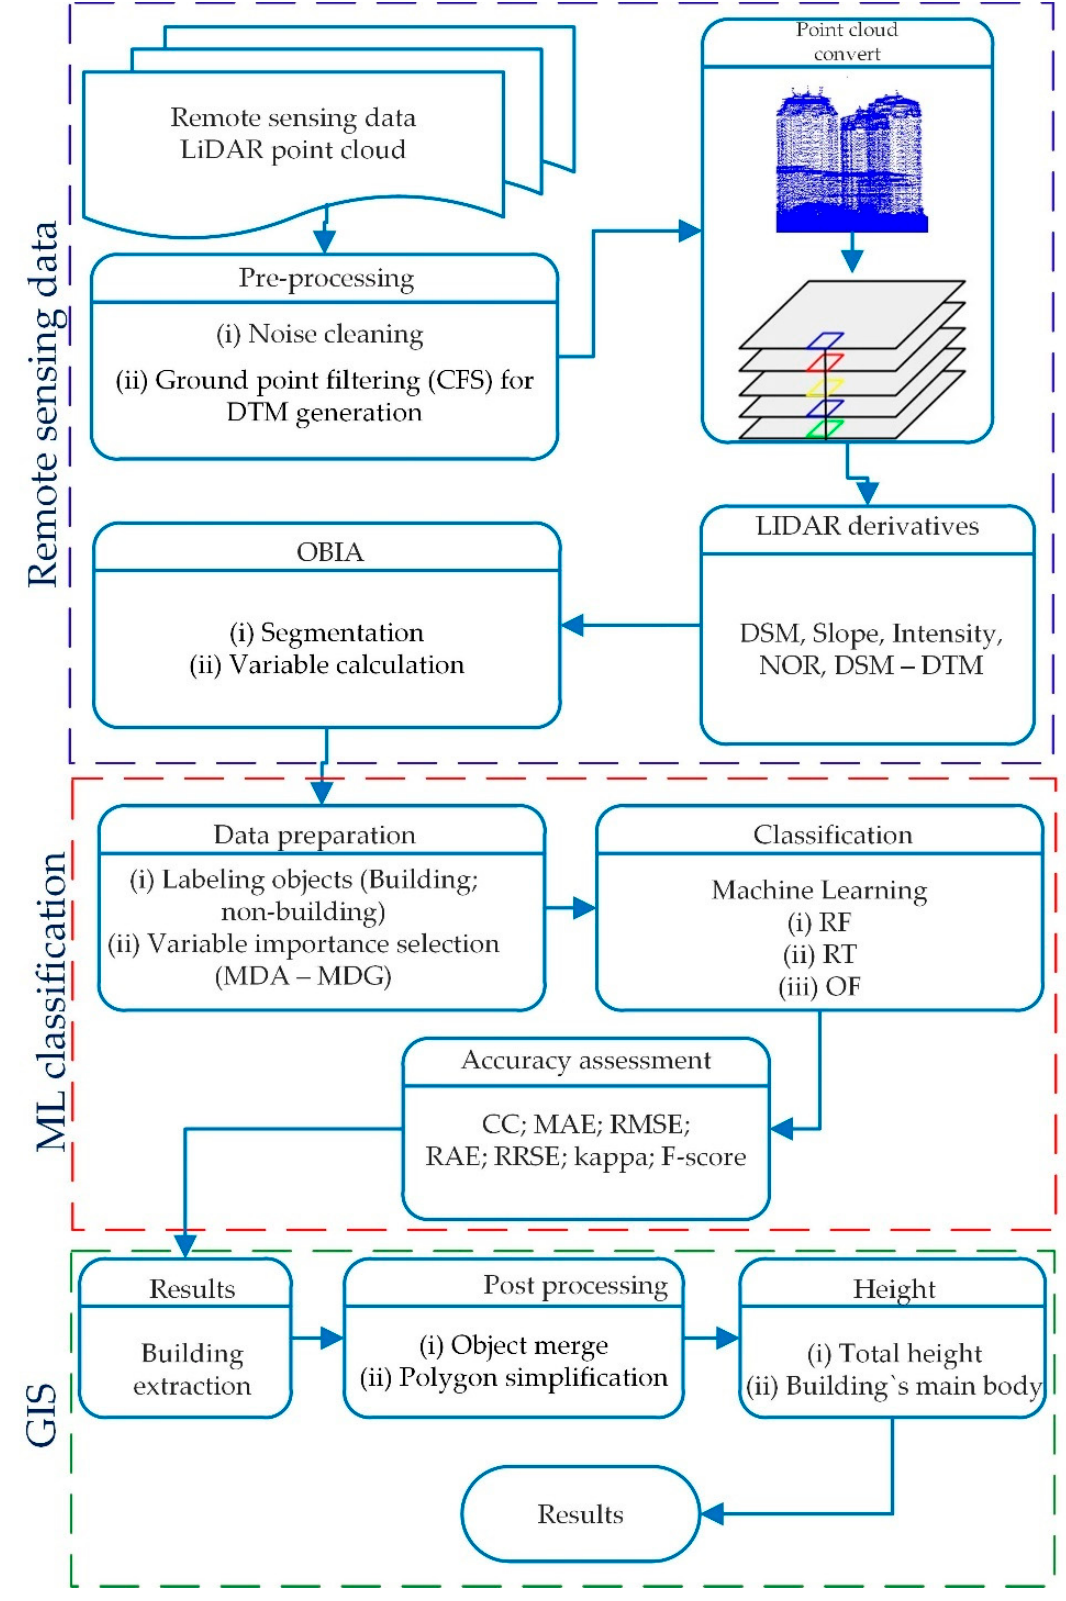
Figure 4. Flowchart of the proposed methodology.